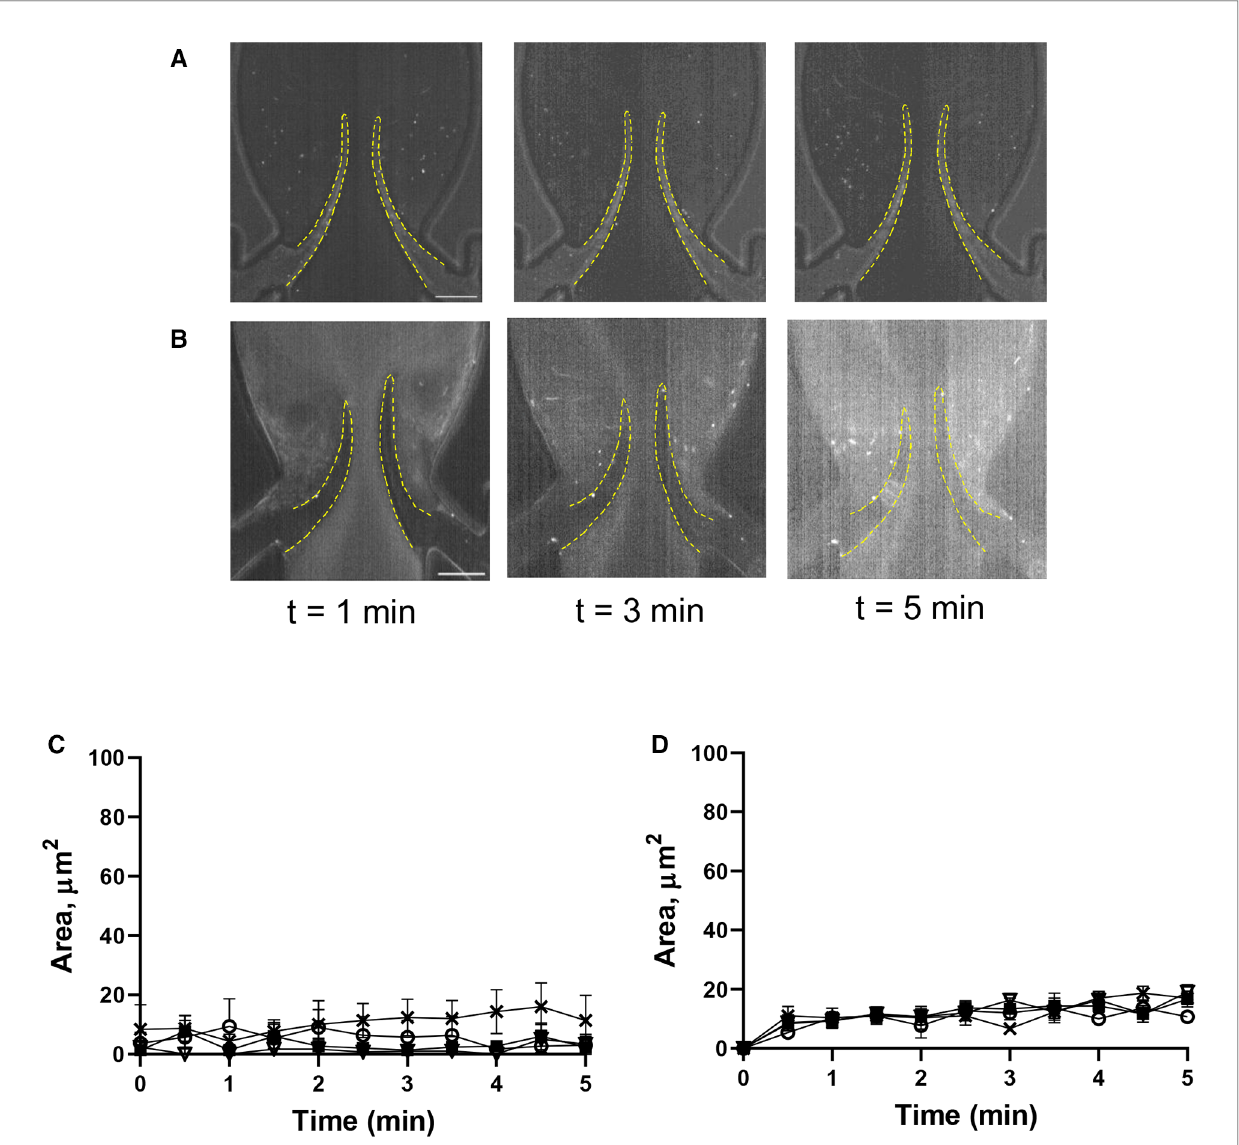
FIGURE 4 Deposition of platelets is mediated by the VWF-GPIb α axis. Platelets were preincubated with OS-1 peptide (M3456 CTERMALHNLC, Alta Bioscience, 12 µM) ( A ), or with 0.1 U/ml thrombin+OS-1 peptide ( B ) for 5 min, fl uorescently labelled, reconstituted with whole blood, and perfused through a symmetrical valve for 5 min. ( C,D ), Quantitation of platelet accumulation on more fl exible (TL area, circles; TS area, open triangles) and less fl exible (TL area, squares; TS area, Xs) lea fl ets. Scale bar 100 µm. Error bars represent SEM, n